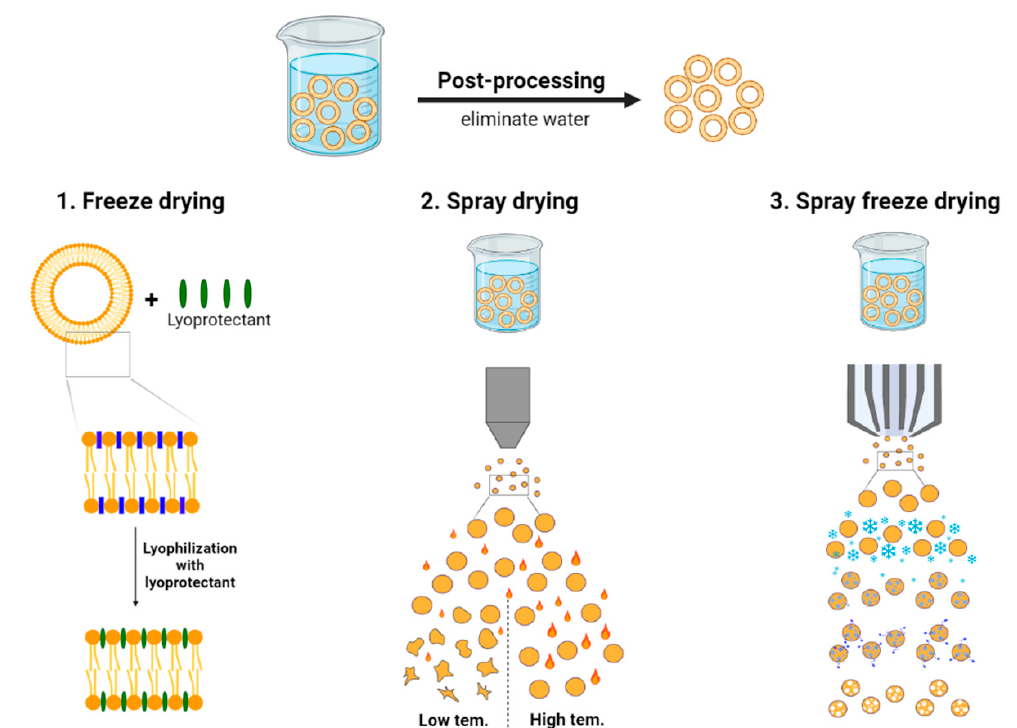
Figure 1. Schematic illustration of post-processing techniques.